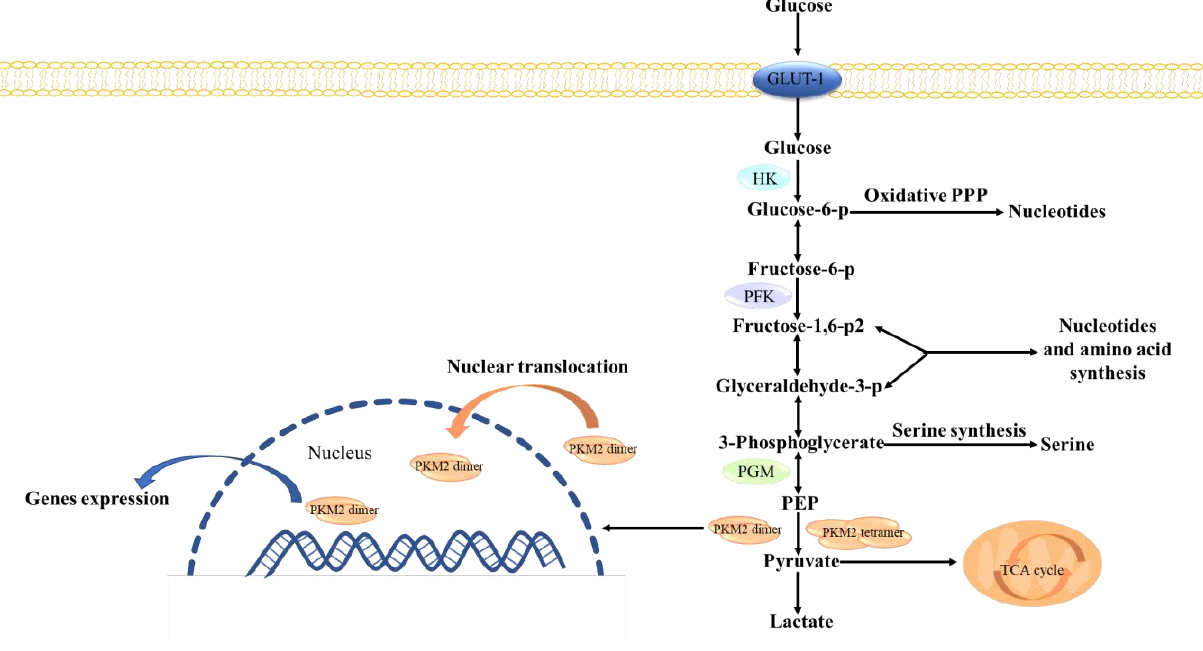
Figure 1. The tetramer and dimer of PKM2 regulate glycolysis and gene transcription in cancer cells. The active tetramer PKM2 is a glycolytic enzyme that transfers PEP into pyruvate, which enters mitochondria and joins in the TCA cycle. The low activity PKM2 dimer leads to the accumulation of glycolytic intermediates to support the biosynthetic precursors of proliferating cells. In addition, dimeric PKM2, as a transcription factor, translocates to the nucleus and activates and regulates transcription of certain genes. GLUT1: Glucose transporter 1, PPP: Pentose Phosphate Pathway, HK: Hexokinase, PFK: Phosphofructokinase 1, PGM: Phosphoglycerate mutase, PEP: Phosphoenolpyru- vate. TCA cycle: Tricarboxylic acid cycle, PKM2: Pyruvate kinase